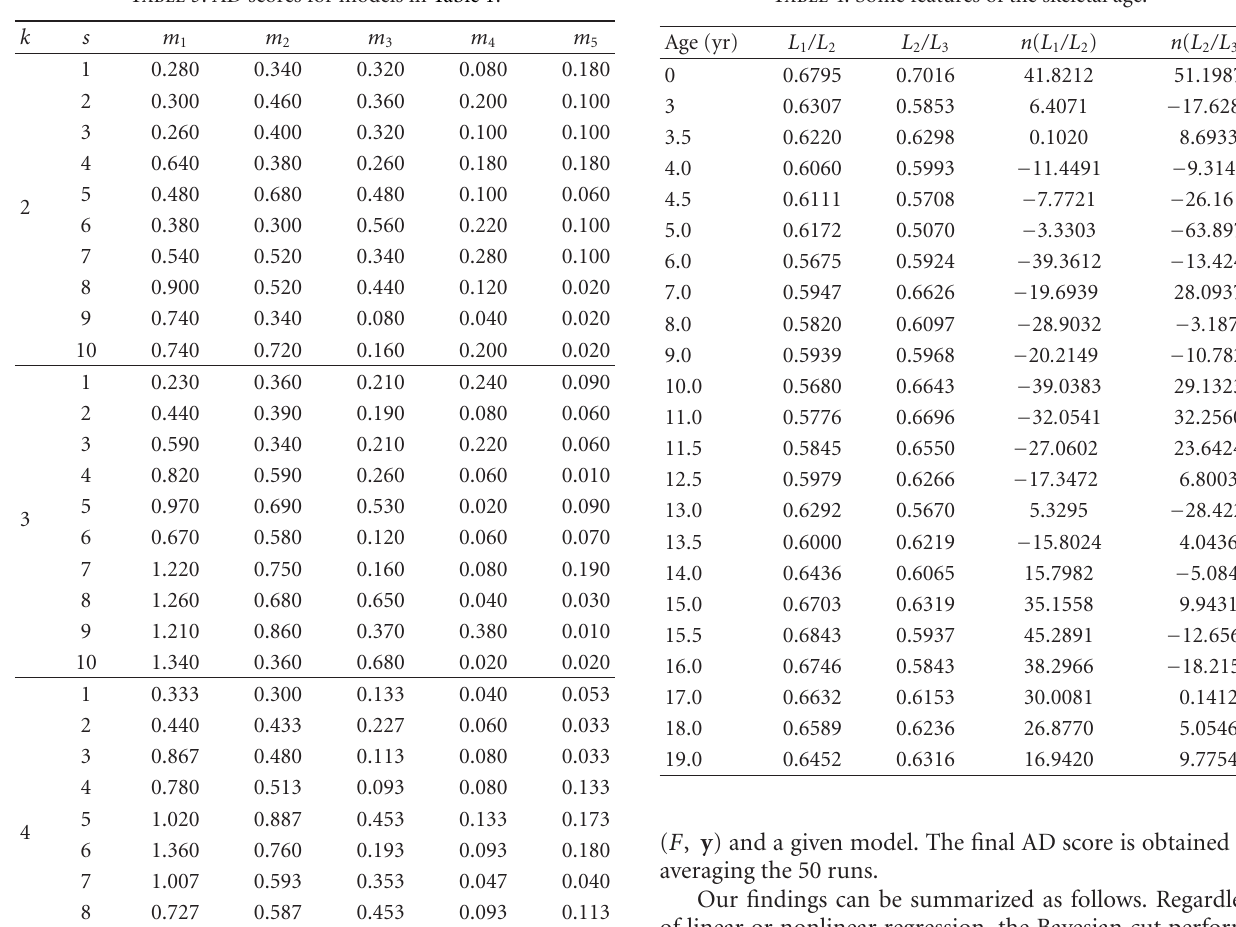
Table 3: AD scores for models in Table 1. Table 4: Some features of the skeletal